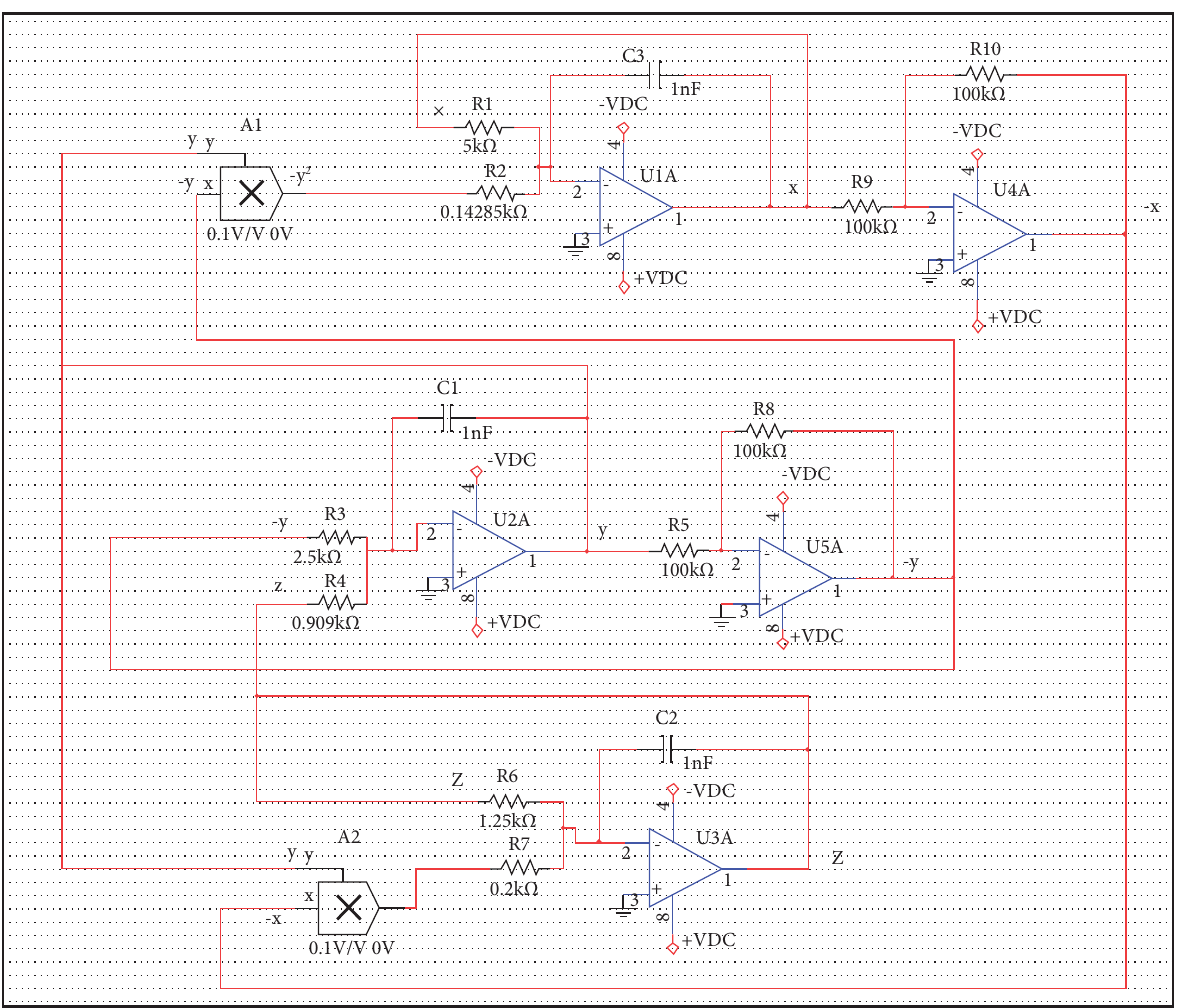
Figure 14: An electronic circuit to simulate the proposed chaotic system given by equation (1) using